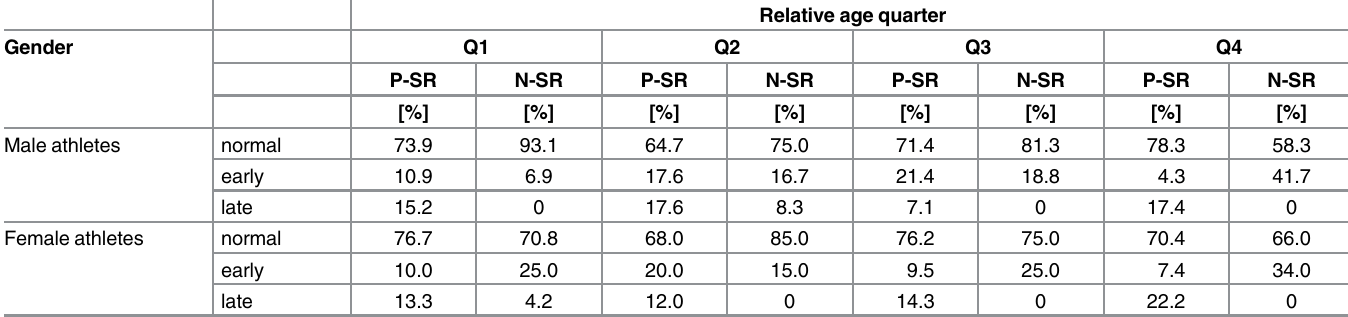
Table 5. Percentages of normal, early and late maturing athletes separated by relative age